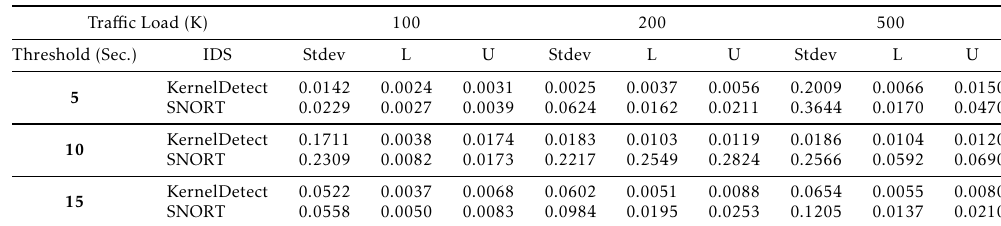
Table 2. 95% confidence interval statistic for inspection time (seconds) between KernelDetect and SNORT where L and U represent their lower and upper bound, respectively.